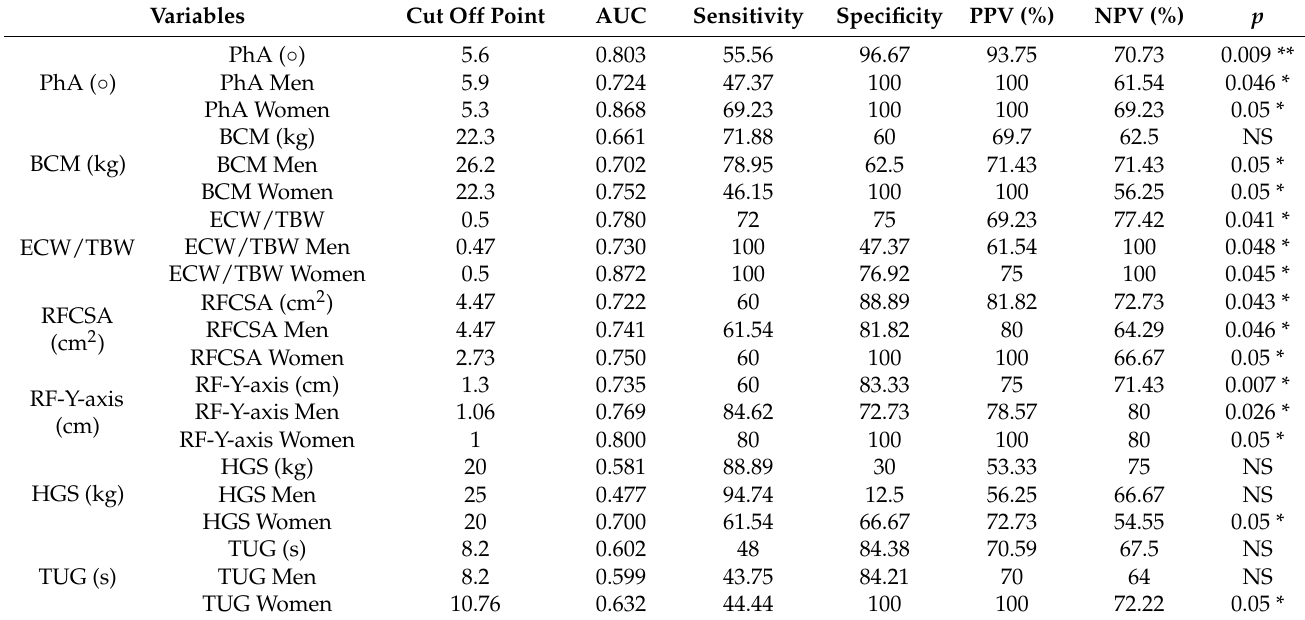
Table 3. ROC curve analysis of the prognostic factor of mortality in cancer patients.